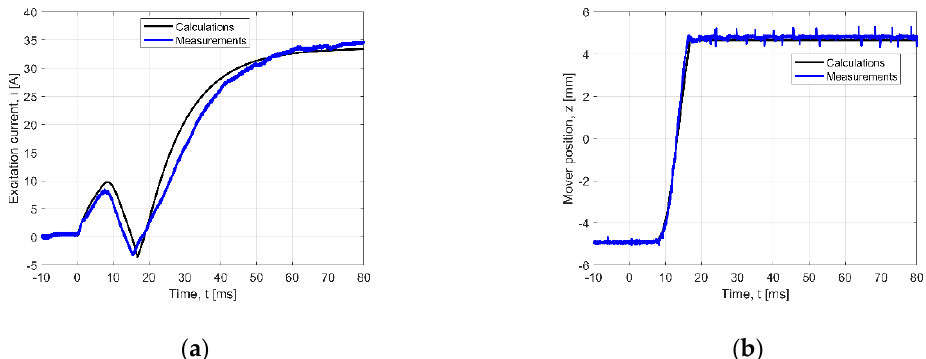
Figure 10. Verified transients for loaded state (springs added): ( a ) current wave, ( b ) position wave